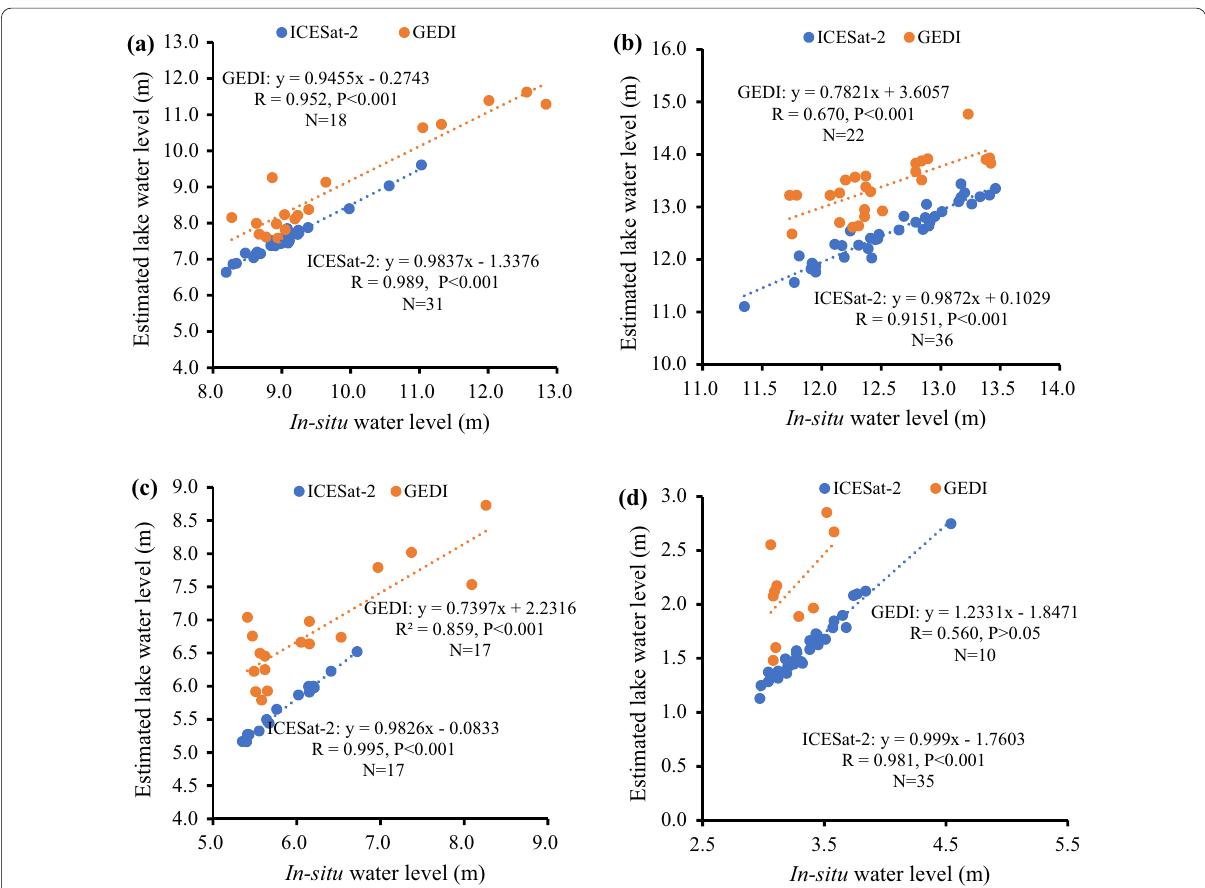
Fig. 3 Correlation evaluation of ICESat-2 and GEDI estimated lake levels with in-situ measurements for a Chaohu Lake, b Hongze Lake, c Gaoyou Lake, and d Taihu